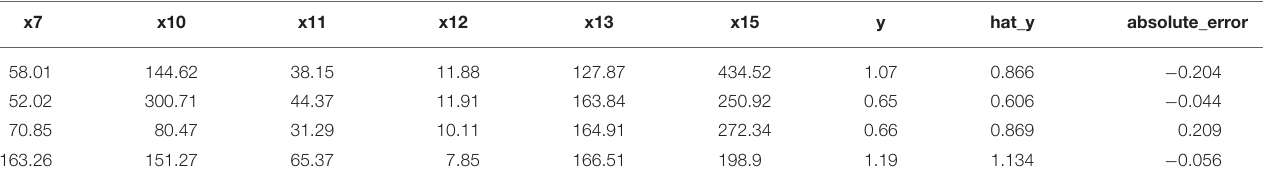
TABLE 4 | The results of the validation set of the biomass and the key physiological/biochemical